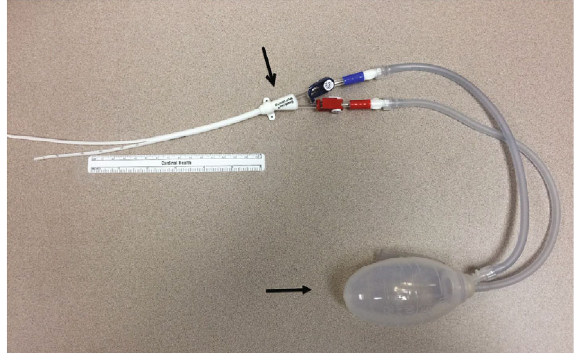
Figure 4: Hybrid closed loop catheter system; table mock-up. Dual channel, separable lumen hemodialysis catheter (open arrowhead) with additional side holes in the shorter venous limb connected to a JP bulb suction bulb (closed